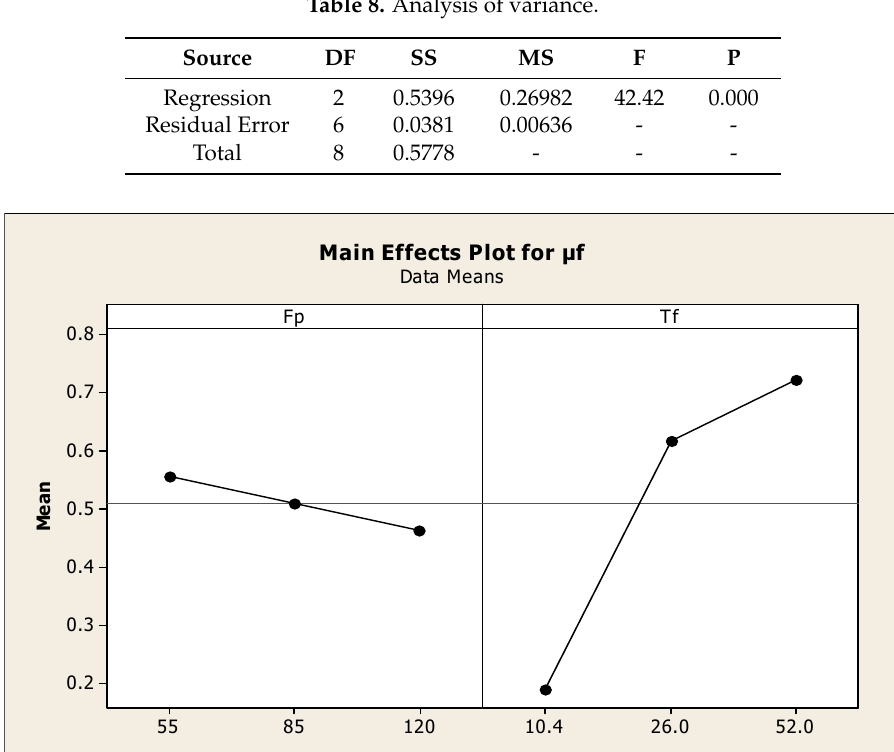
Figure 6. Effect of friction pressure and torque on µ f